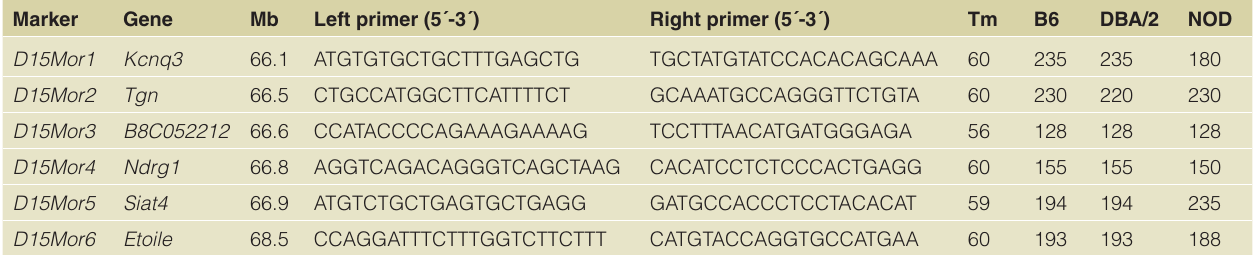
Table 1. Primers used to amplify novel markers. Simple sequence length repeats were found from inspection of relevant genomic sequences. The location of the nearest known gene, the genomic position (in Mb from the UCSC July 2007 freeze) of the repeat; the primers used to amplify it; the annealing temperature used (Tm), and the sizes of alleles from B6, DBA/2 and NOD mice, are indicated.